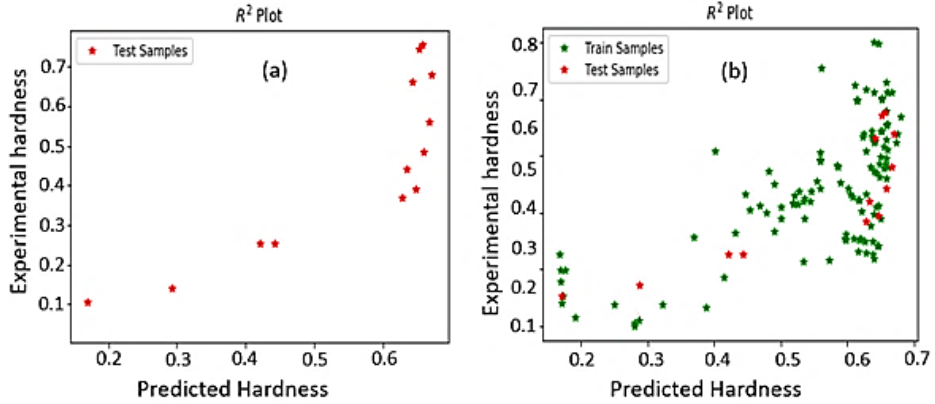
Figure 6. Hardness prediction by machine learning using the NN model for ( a ) the testing data and ( b ) both training and testing data. The red star symbol denotes the predicted hardness of the testing data, and the green star symbol denotes the predicted hardness of the training data. Table 2. Experimental and NN model-predicted Vickers hardness of HEAs.